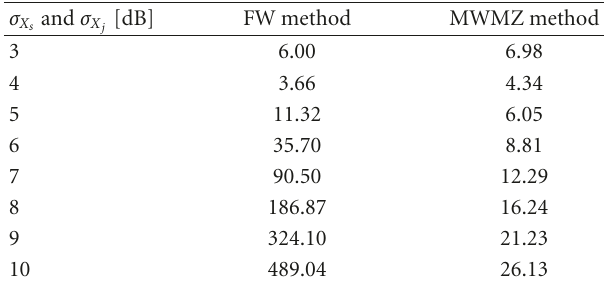
Table 2: Kullback-Leibler Distance between the simulation and the analysis ( × 10 − 4